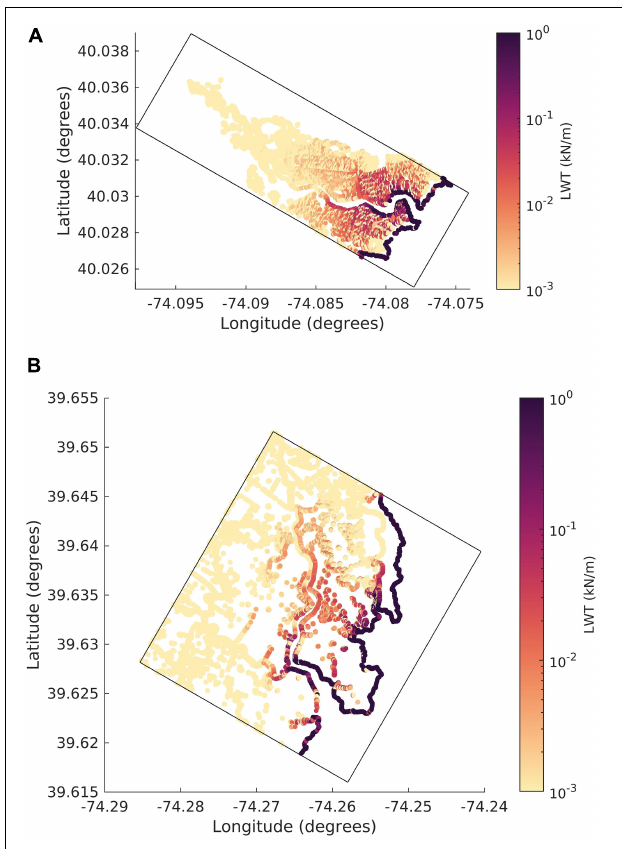
FIGURE 7 | Integrated lateral wave thrust map integrated over 31 days. (A) Reedy Creek and (B) Dinner Creek